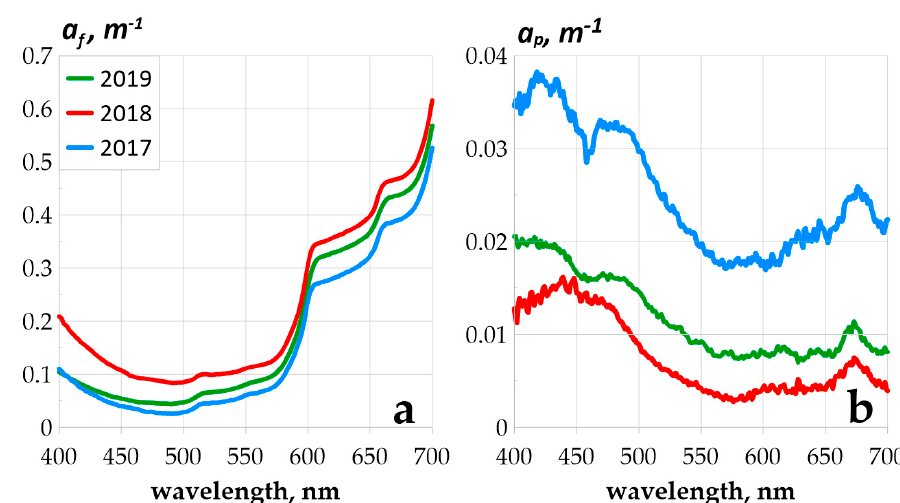
Figure 6. Absorption spectra of the filtrate ( a ) and suspended particles ( b ) for three stations in 2017–2019 measured by integrated cavity absorption meter (ICAM).